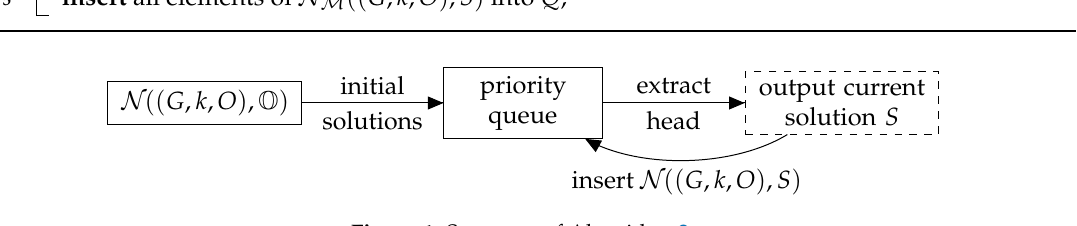
Figure 1. Structure of Algorithm 2.